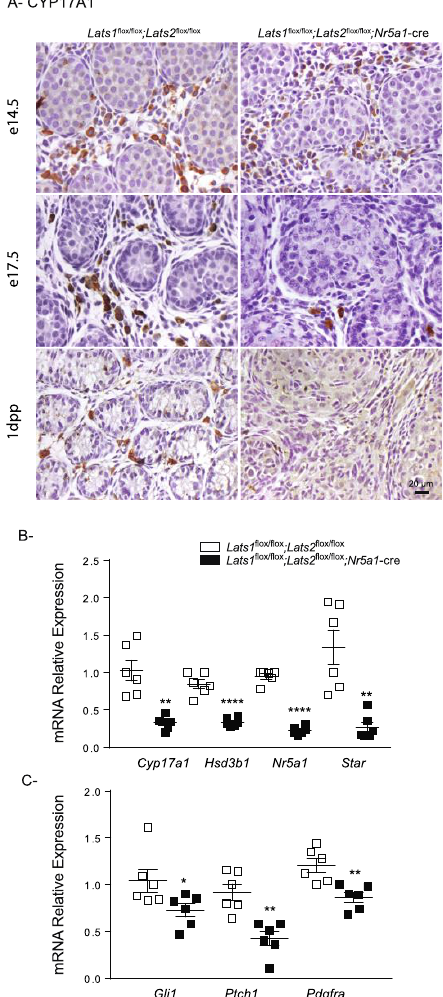
Figure 7. Loss of Lats1 and Lats2 affects FLCs. ( A ) Immunohistochemical analysis of CYP17A1 expression in testes of mice of the indicated genotypes. Scale bar (lower right) is valid for all images. ( B , C ) RT-qPCR analysis of steroidogenesis ( B ) and progenitor FLC markers ( C ) in testes of 1dpp mice of the indicated genotypes ( n = 6 animals/genotype). All data were normalized to the housekeeping gene Rpl19 and are expressed as means (columns) ± SEM (error bars). Asterisks = significantly different from control (* p < 0.05; ** p < 0.01; **** p < 0.0001).